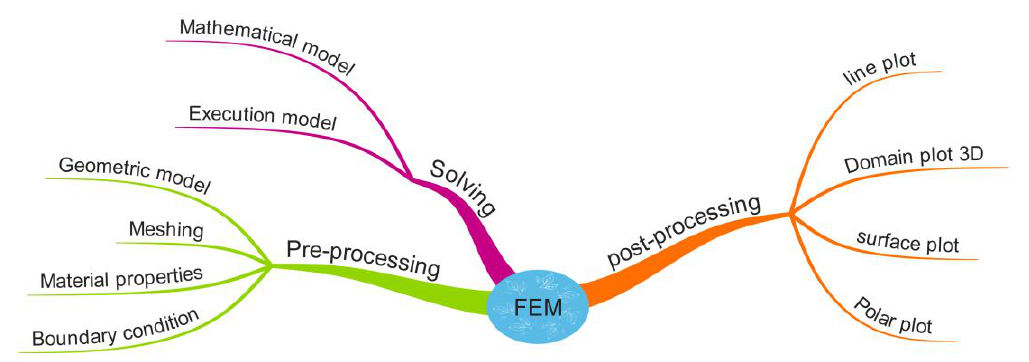
Figure 10. Finite element method (FEM) modeling in COMSOL Multiphysics.